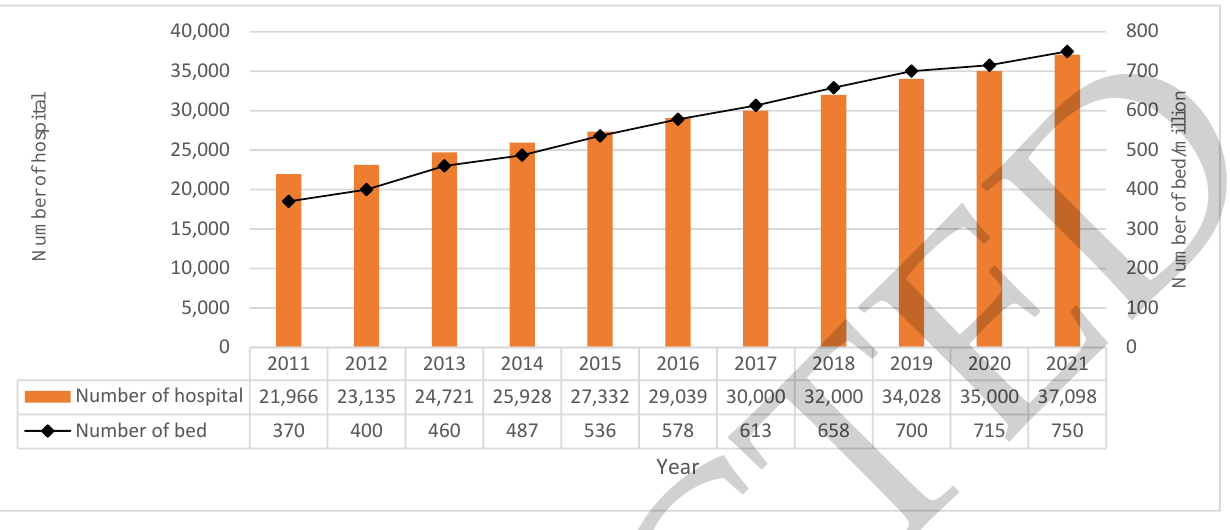
Figure 1. The change in the number of hospitals in China, 2011 – 2021.